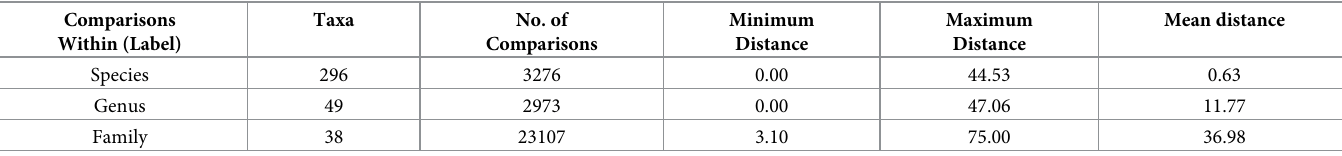
Table 2. Summary of K2P pairwise genetic distances (%) at different taxonomic levels. Comparisons Within